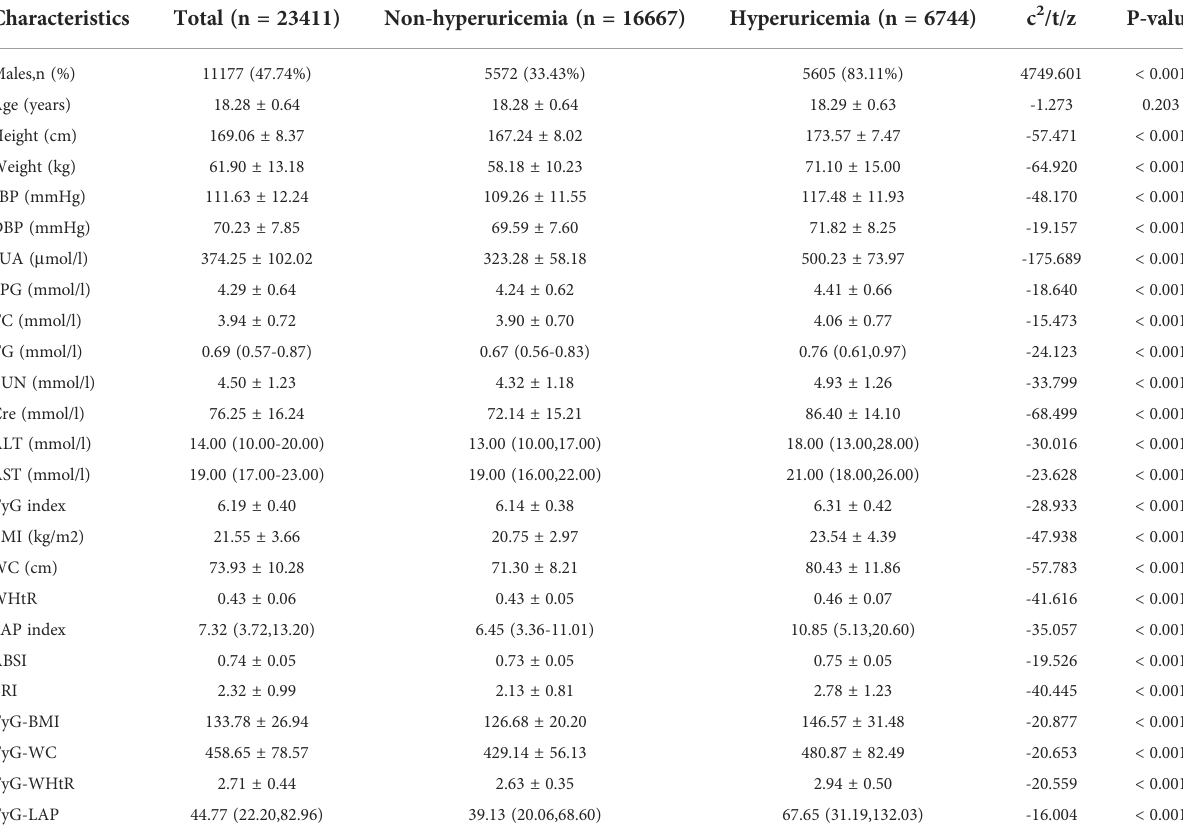
TABLE 1 Comparison of baseline characteristics of study participants who developed hyperuricemia or not.